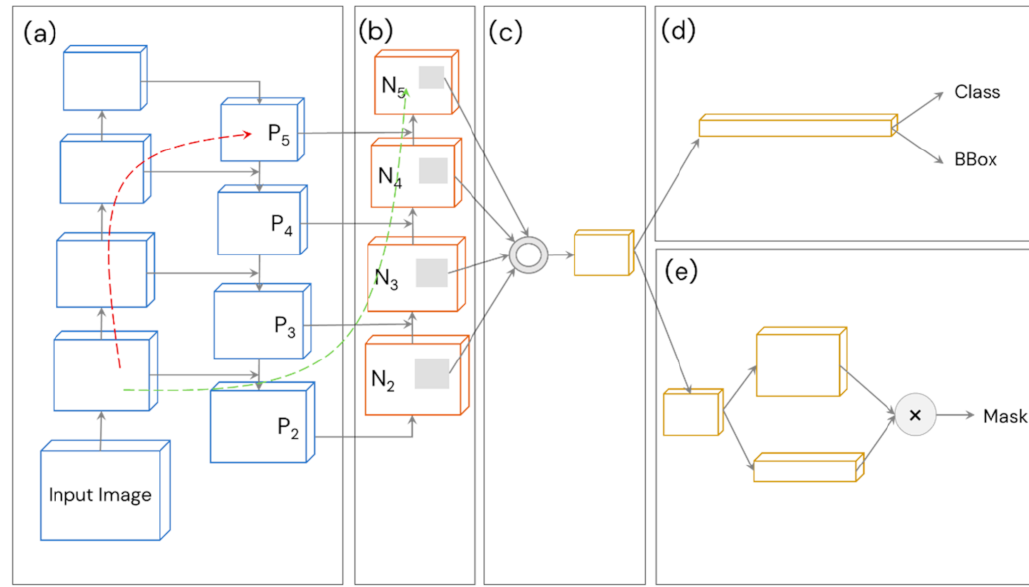
Figure 7. Architecture of PANet, which inspired the path aggregation in YOLOv4’s neck. ( a ) FPN backbone; ( b ) bottom-up path augmentation; ( c ) adaptive feature pooling; ( d ) box branch; ( e ) fully-connected fusion (concatenation is done instead of addition for